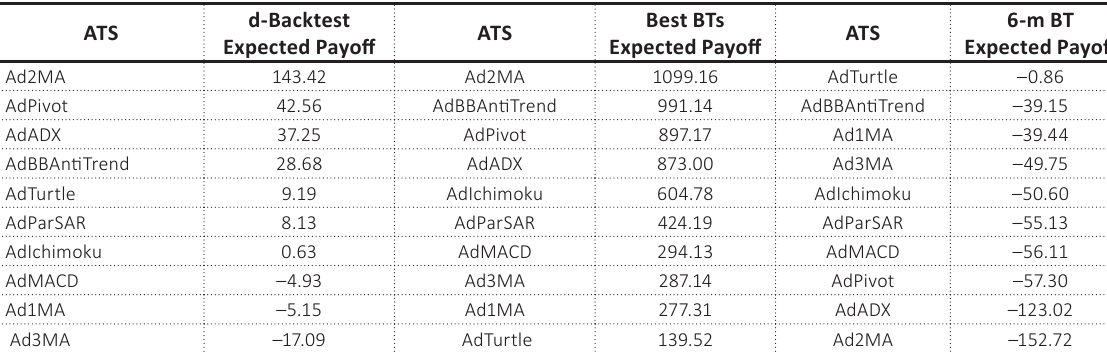
Table B4. Total results for Expected Payoff